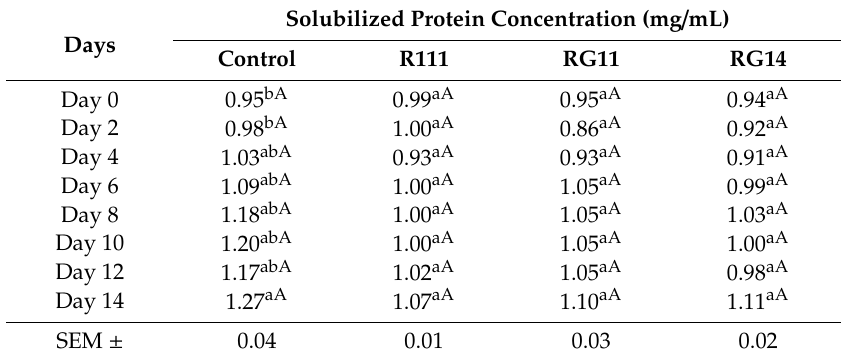
Table 2. Solubilized protein concentration of untreated and fermented palm kernel cake